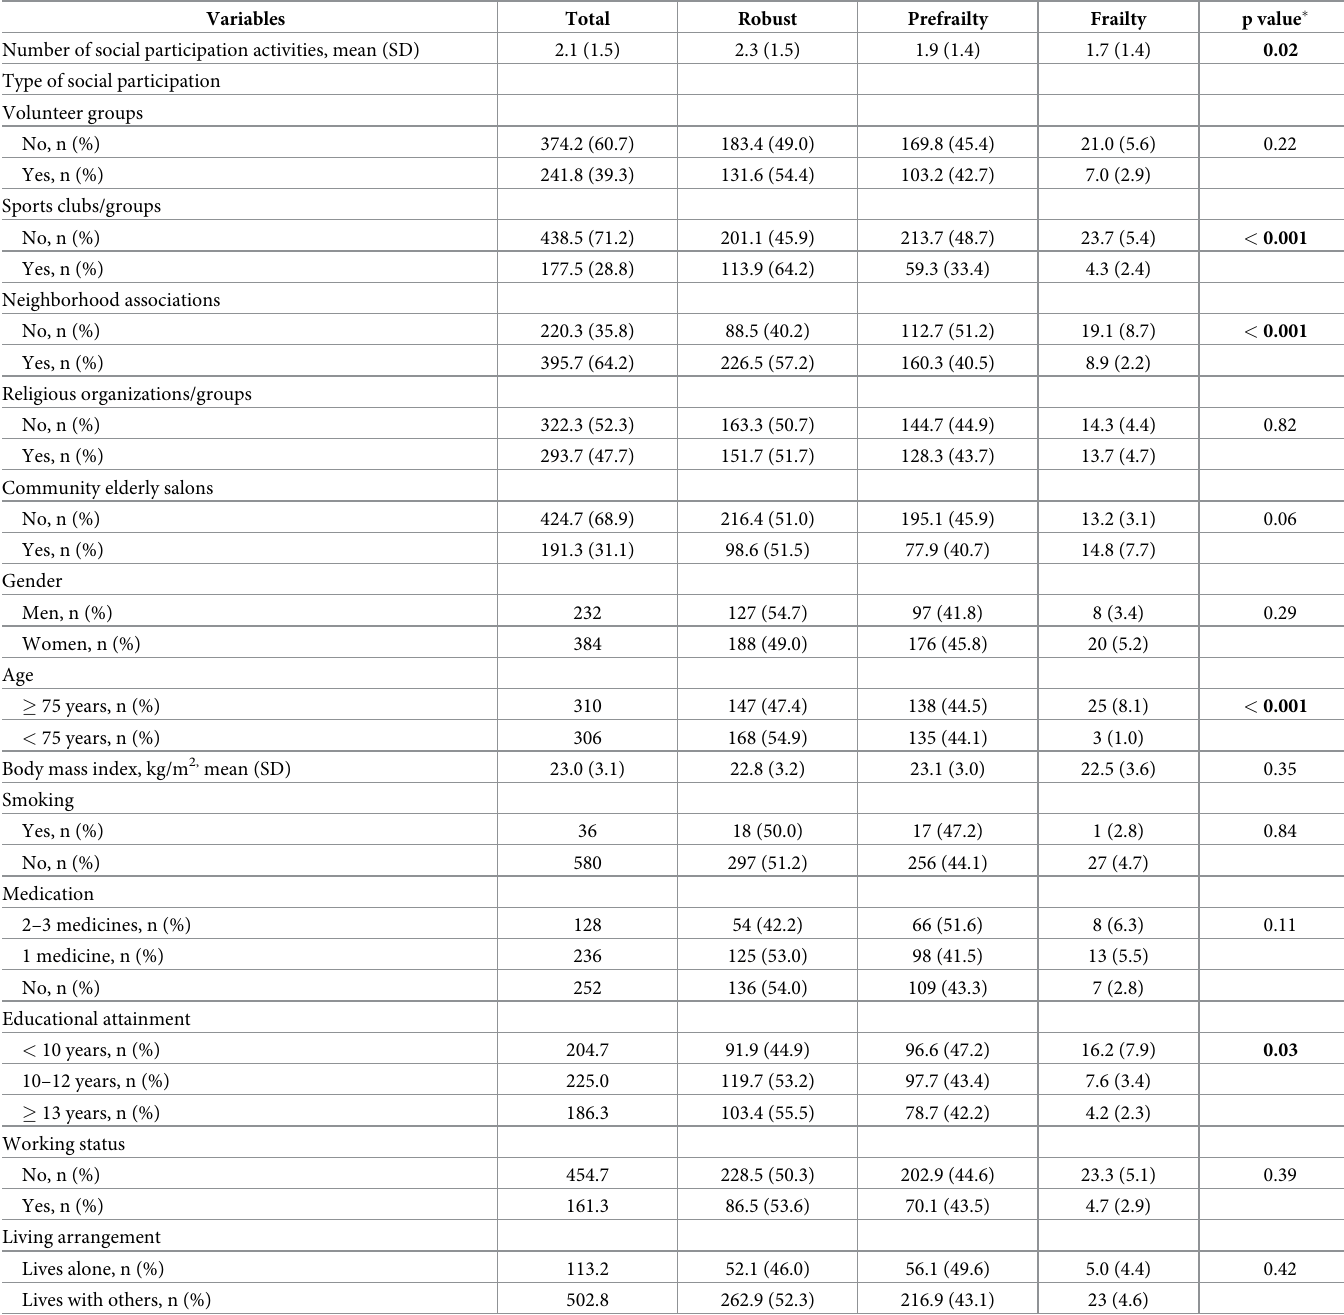
Table 1. Participant characteristics by frailty status based on data after multiple